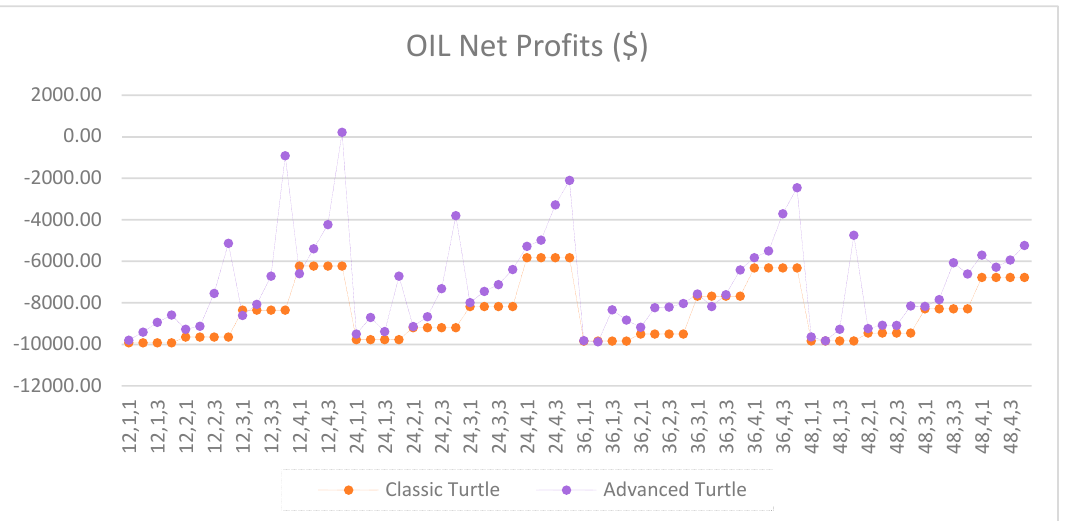
Figure A13. Net profits of OIL between the classic and the advanced Turtle systems for every combination of N, X, Y for the fast parameters (20, 40).